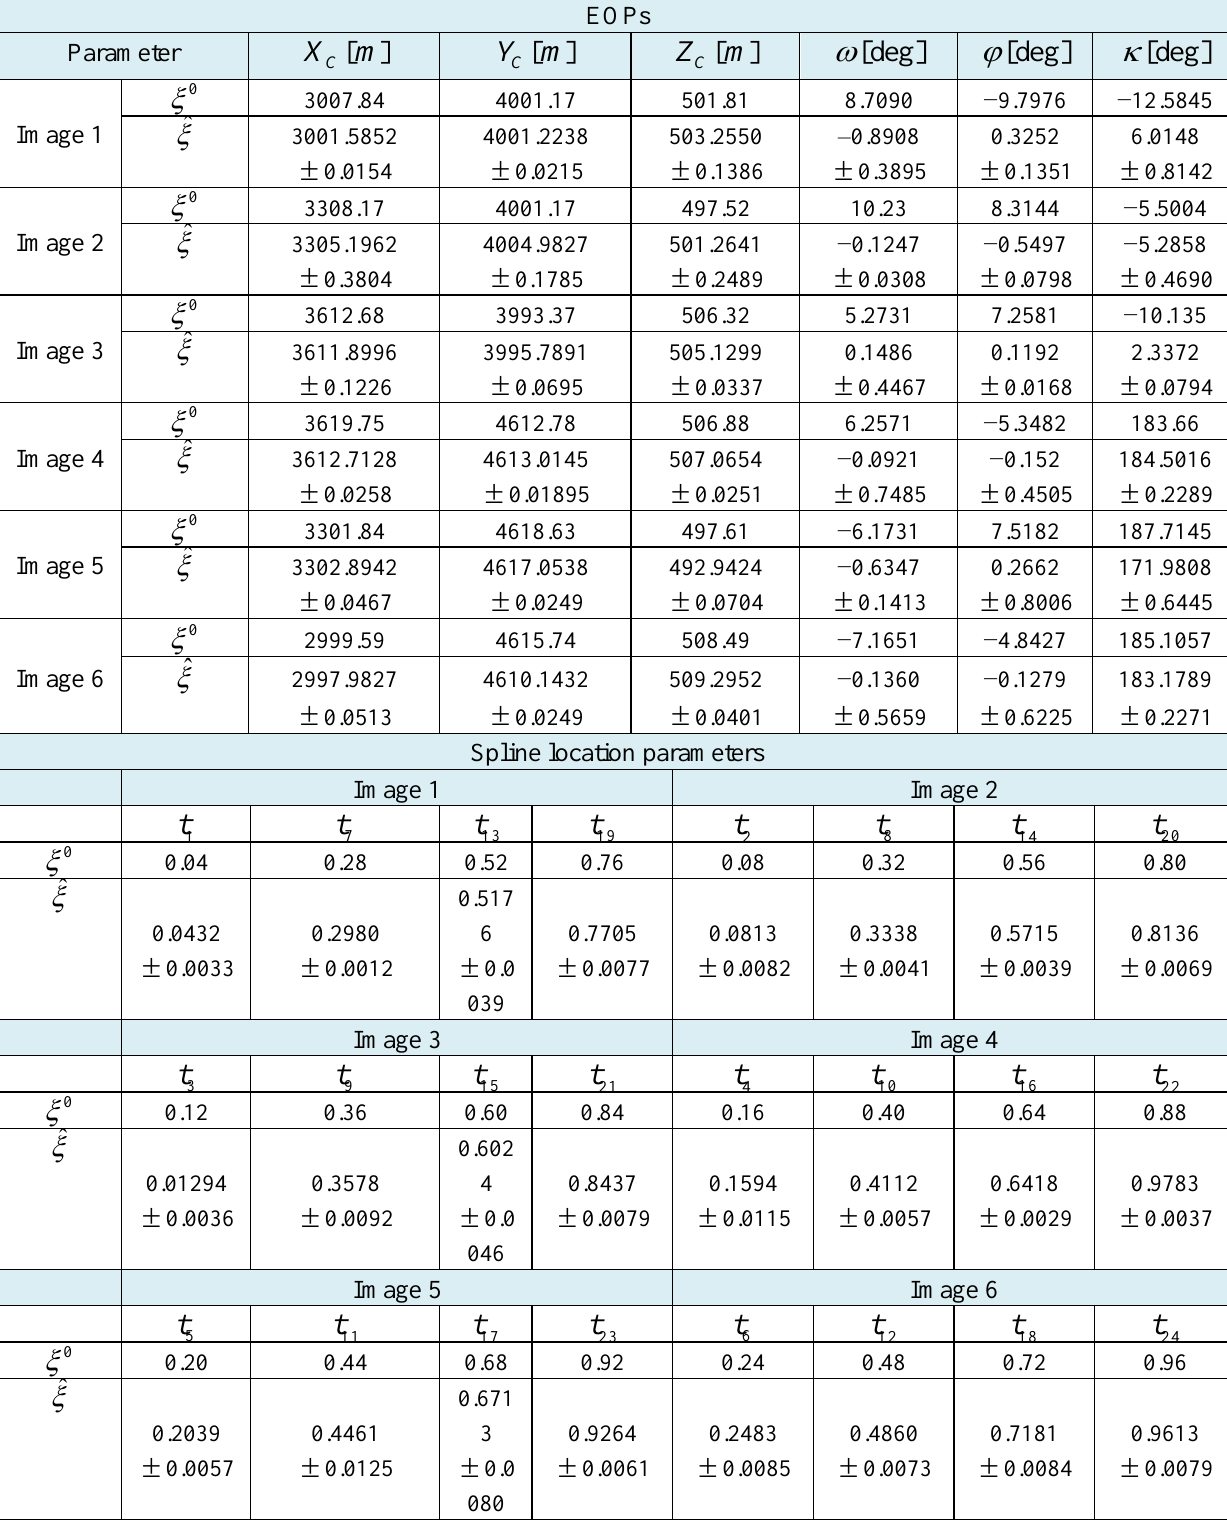
Table 6. EOP and spline location parameter